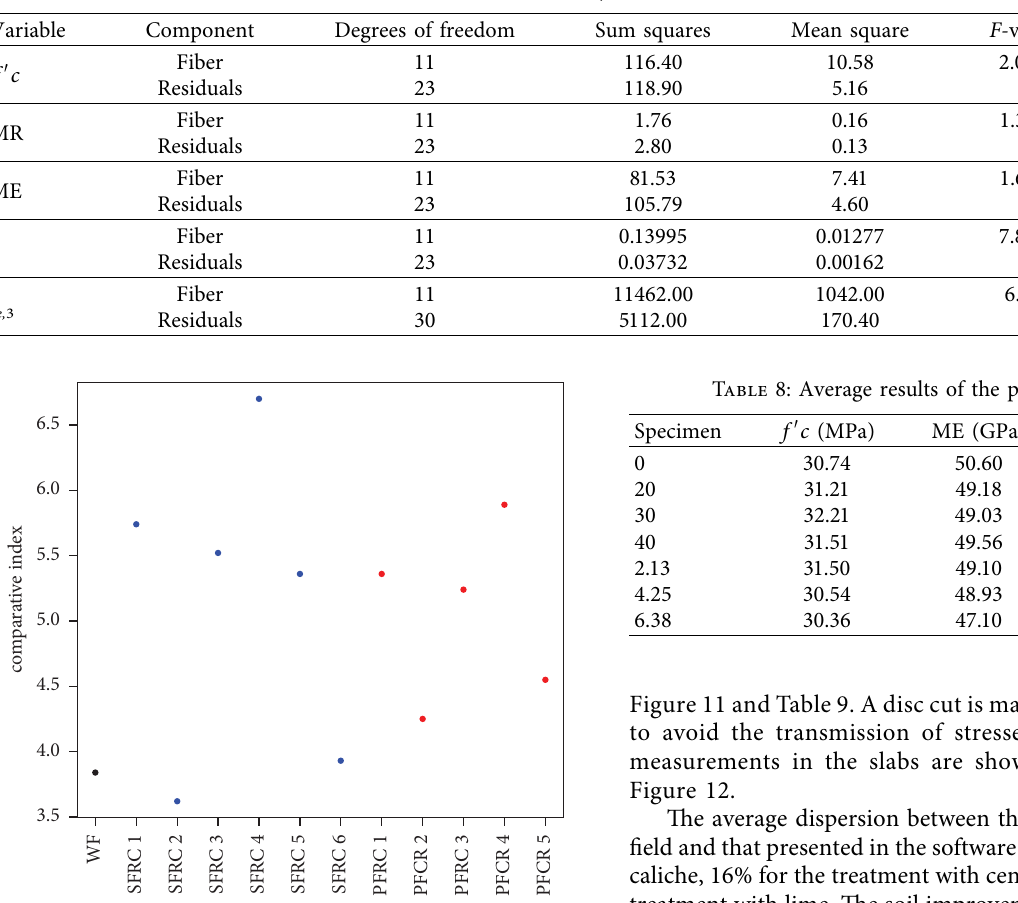
Figure 7: Comparative index.